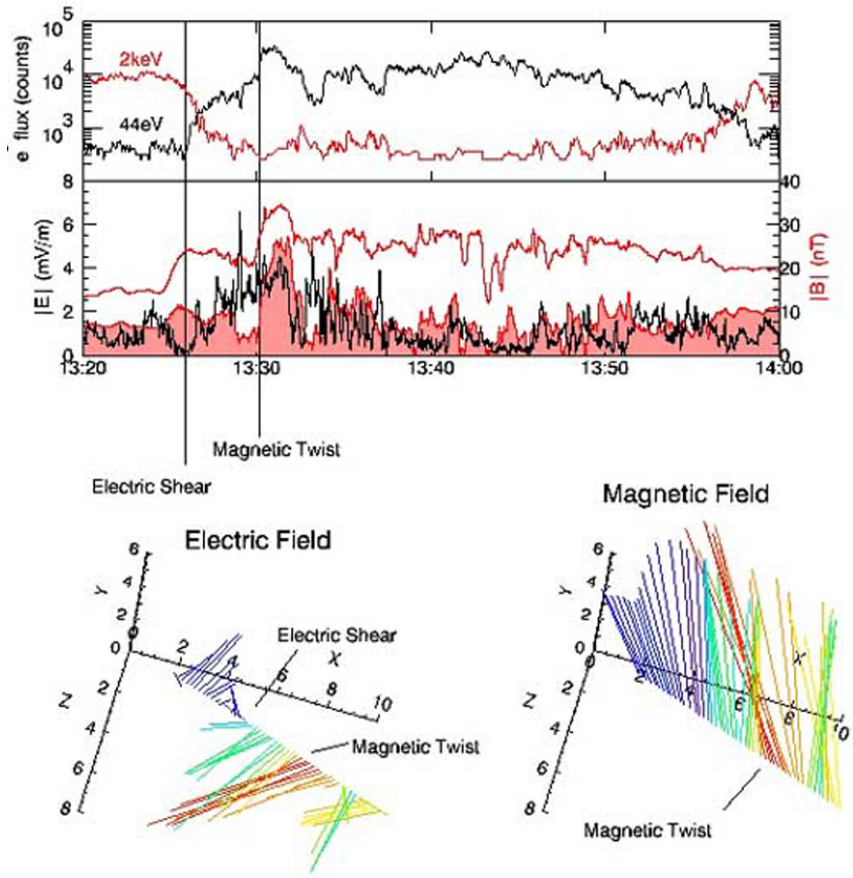
Fig. 20. Top panel: two selected energy channels sensitive to typical magneto- spheric electrons (2keV, red curve) and cusp/magnetosheath electrons (44eV, black curve) from the Cluster electron experiment PEACE, plotted in compar- ison to the total electric (black curve) and magnetic (red curve) field in the central panel. Also in the central panel, the magnetic field component in the di- rection of the motion of the transient at 13:30 UT is plotted as a shaded red curve. In the bottom two panels, we dis- play the electric (left panel) and mag- netic (right panel) vectors as a spatial feature along the trajectory of the mov- ing structure in GSE coordinates ( R E units) with an arbitrary origin in the vicinity of Cluster at 13:30 UT. The in- tensity of the field is colour-coded as to overcome projection ambiguities in the 3-D presentation. Two major events are labelled (see text for more details on this